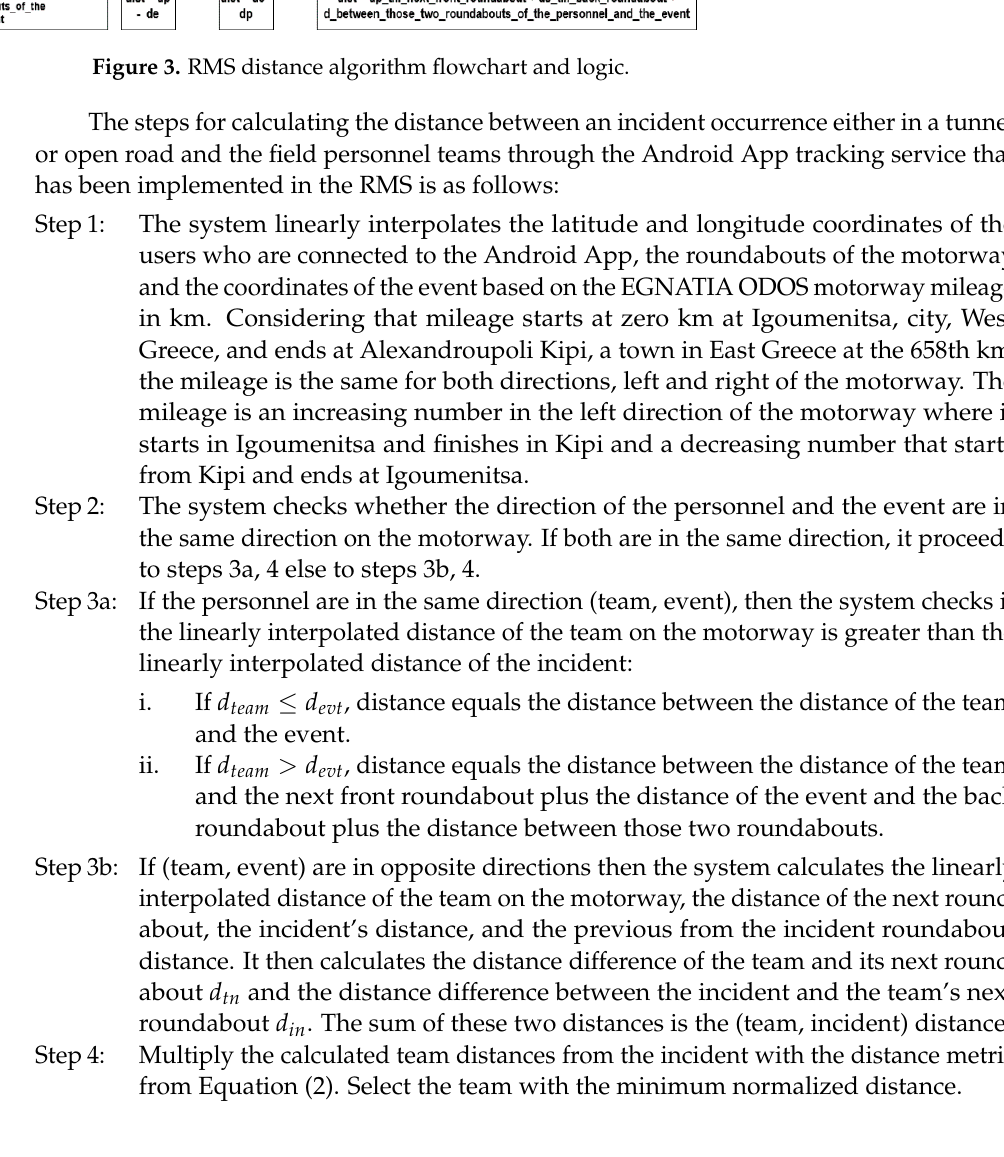
Figure 3. RMS distance algorithm flowchart and logic.